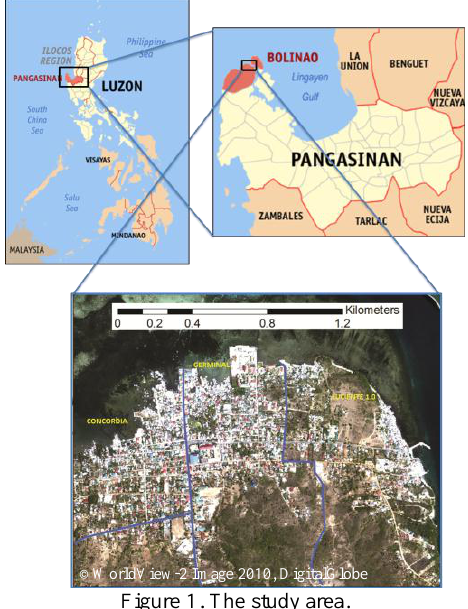
Figure 1. The study area.